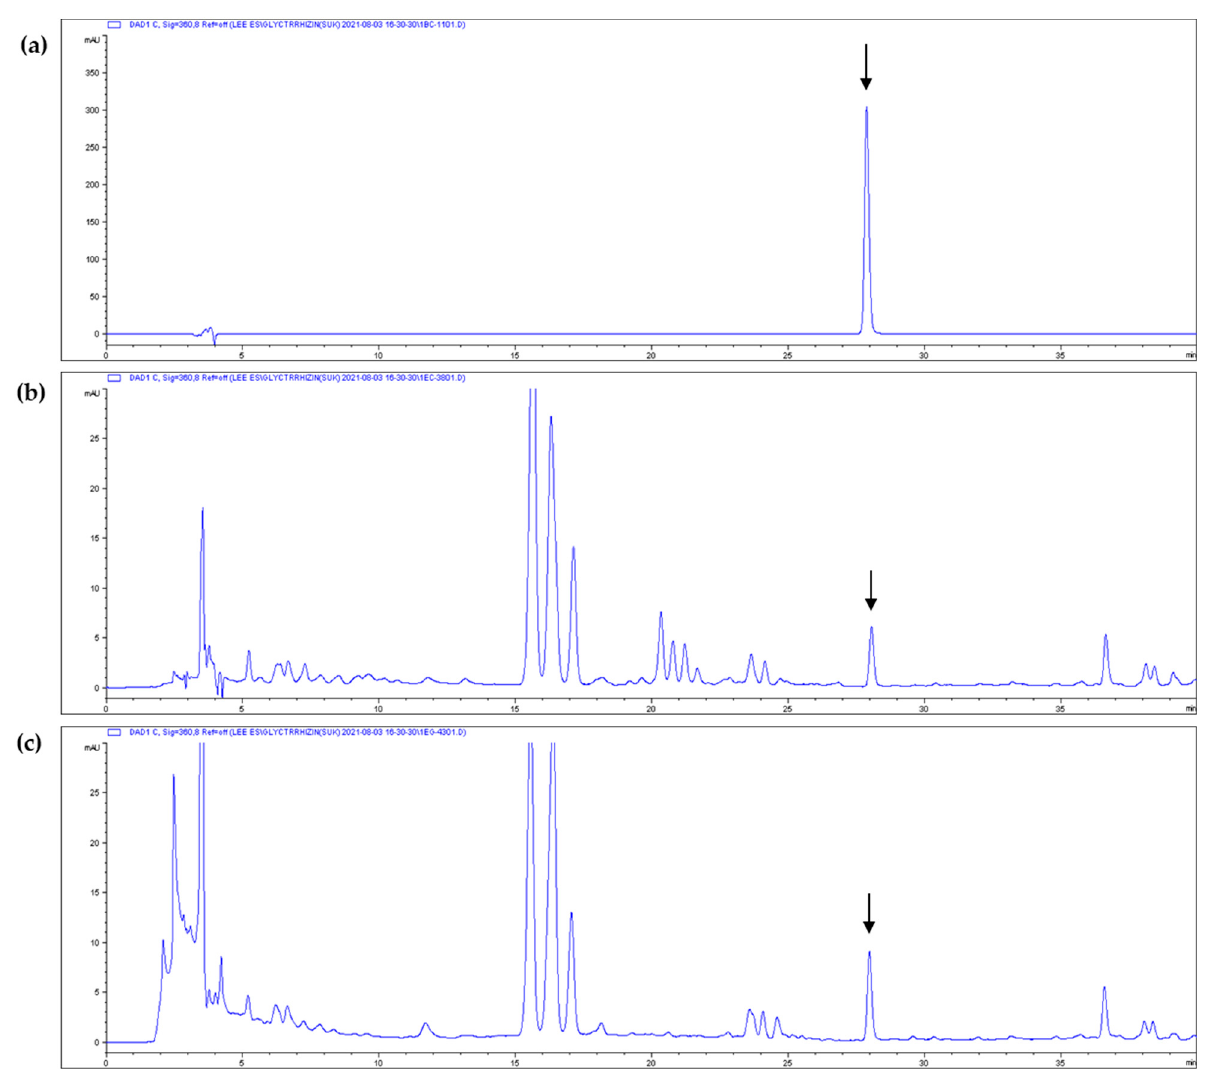
Figure 2. High-performance liquid chromatography (HPLC) chromatograms of isoliquiritigenin and licorice extract: ( a ) isoliquiritigenin standard, ( b ) non-heated licorice (WC) and ( c ) heat-treated licorice (WH-130). Arrows indicate the isoliquiritigenin peak.